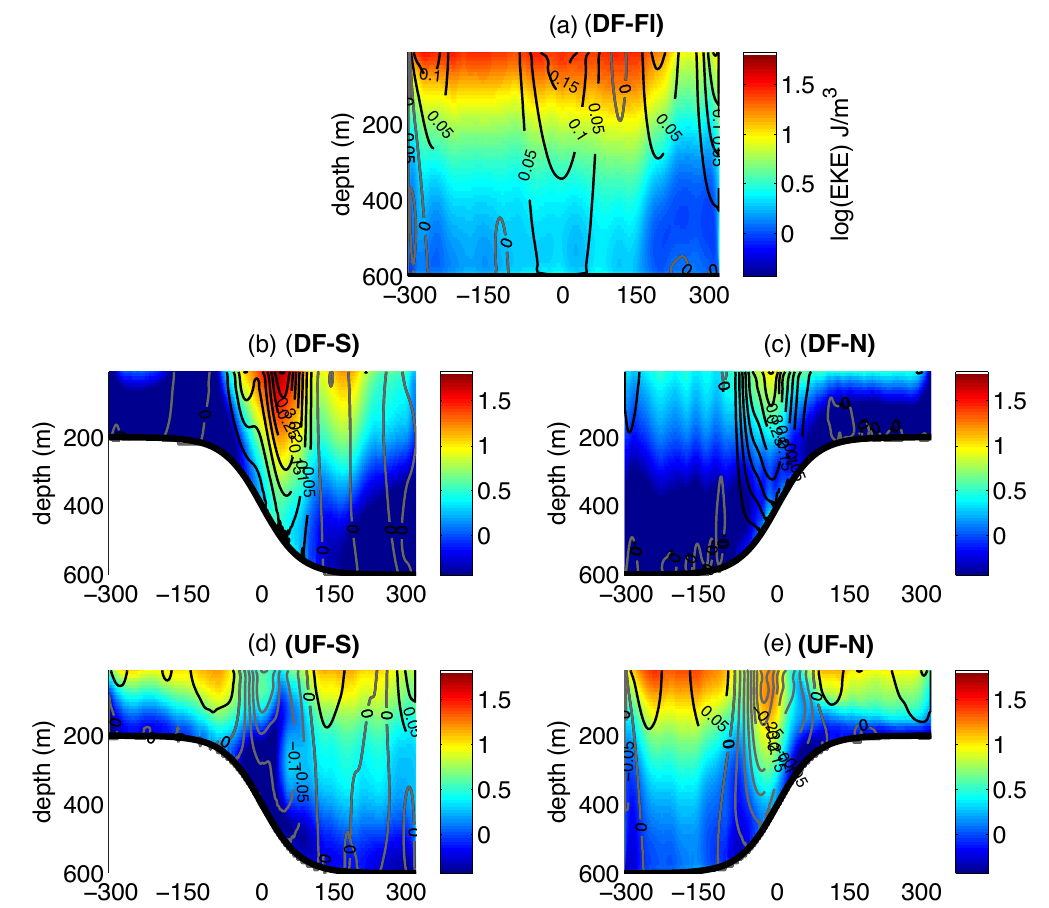
x , t ) /2) from day 800 to 1000. Values are displayed Figure 9. Zonal and time averaged EKE ( ρ ( u (cid:48) 2 + v (cid:48) 2 in log 10 scale. Contour lines show zonal and time averaged zonal velocity ( u ). Black line represents positive values. Gray line represents negative values. Panels ( a – e ) correspond to experiments (1)–(5) described in Table 1, and experiment ID is